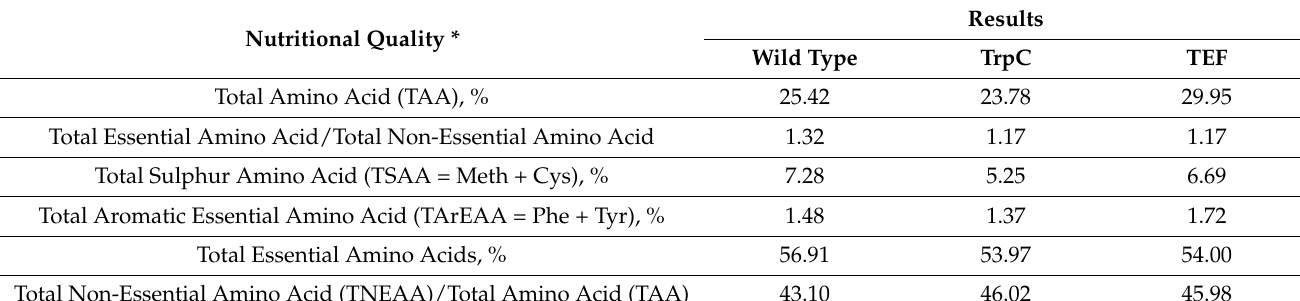
Table 2. Calculated nutritional quality of the wild type and transgenic Th. thermophilus rF-859 clones TrpC and TEF (* Nutritional quality was calculated as described by Lata and Atri [54]). Nutritional Quality